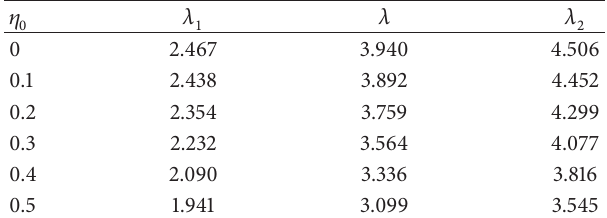
Table 7: Numerical results for sliding end-simply supported DWC- NTs: in columns 1 and 3, the first two dimensionless fundamental frequencies 𝜆 1 and 𝜆 2 , with 𝑐 12 = 0 , are reported, while in column 2, the first frequency 𝜆 , with 𝑐 12 = 0.0694 TPa, is